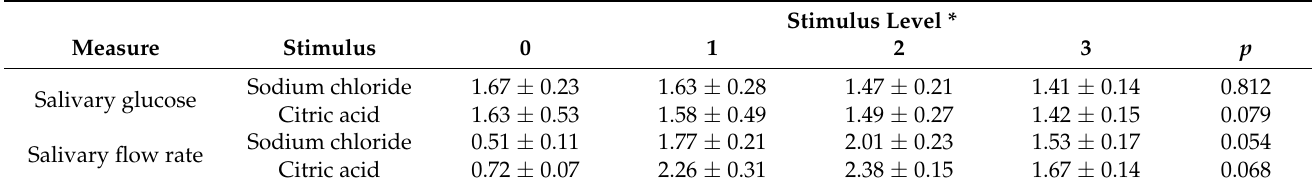
Table 4. Effects of different stimulation conditions on salivary glucose. (Unit: mmol/L). Stimulus Level